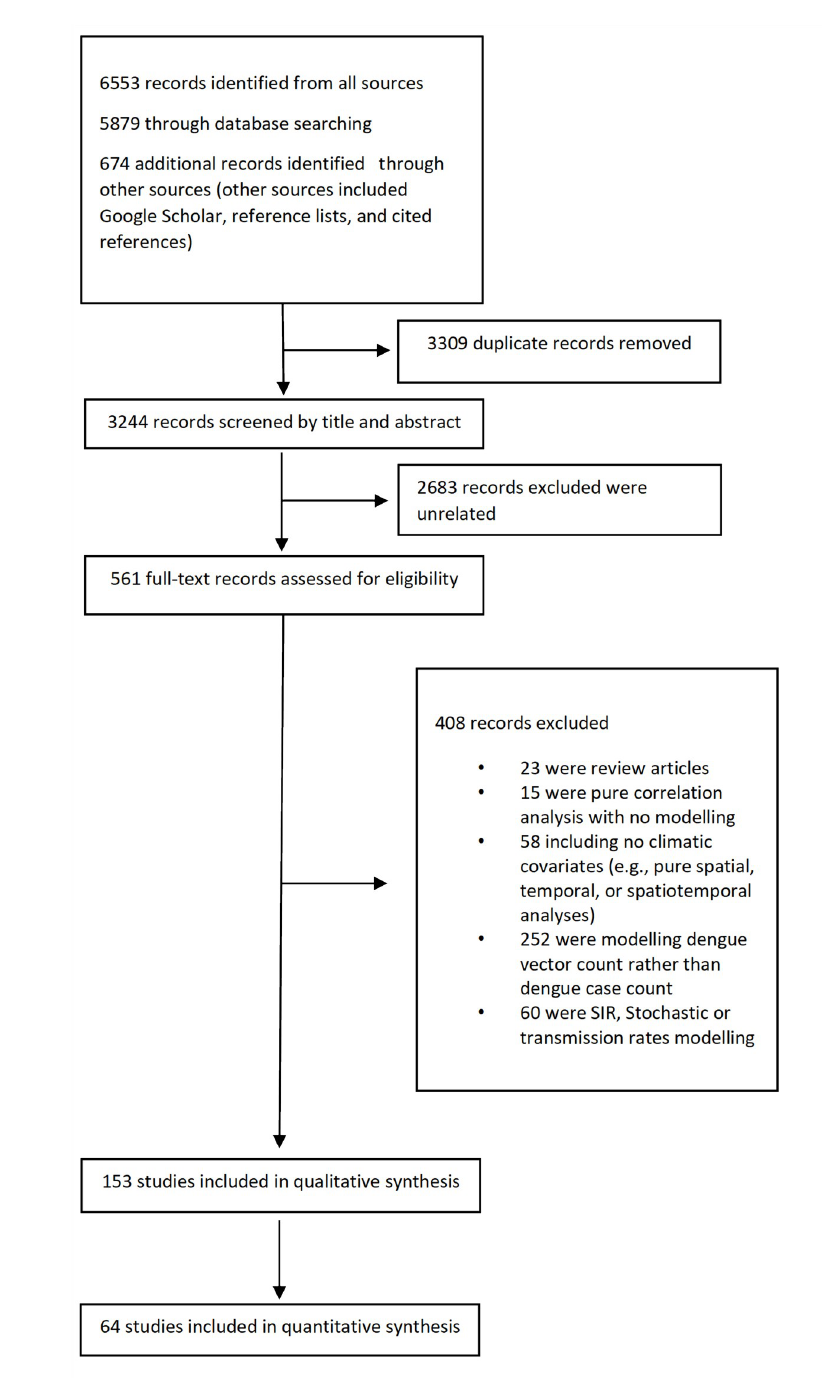
Fig 1. PRISMA flow diagram illustrating study selection process.